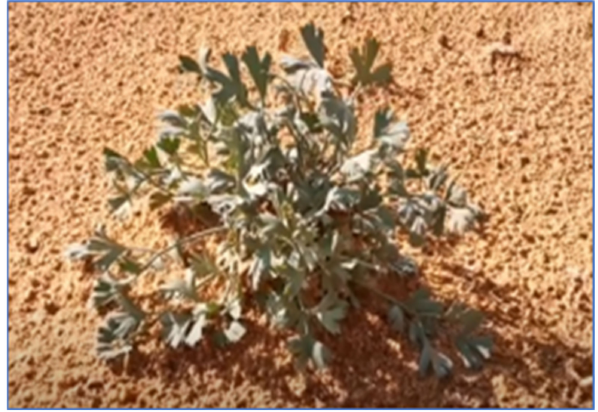
Figure 1. D. flabellifolia Boiss. plant species collected from the Hail